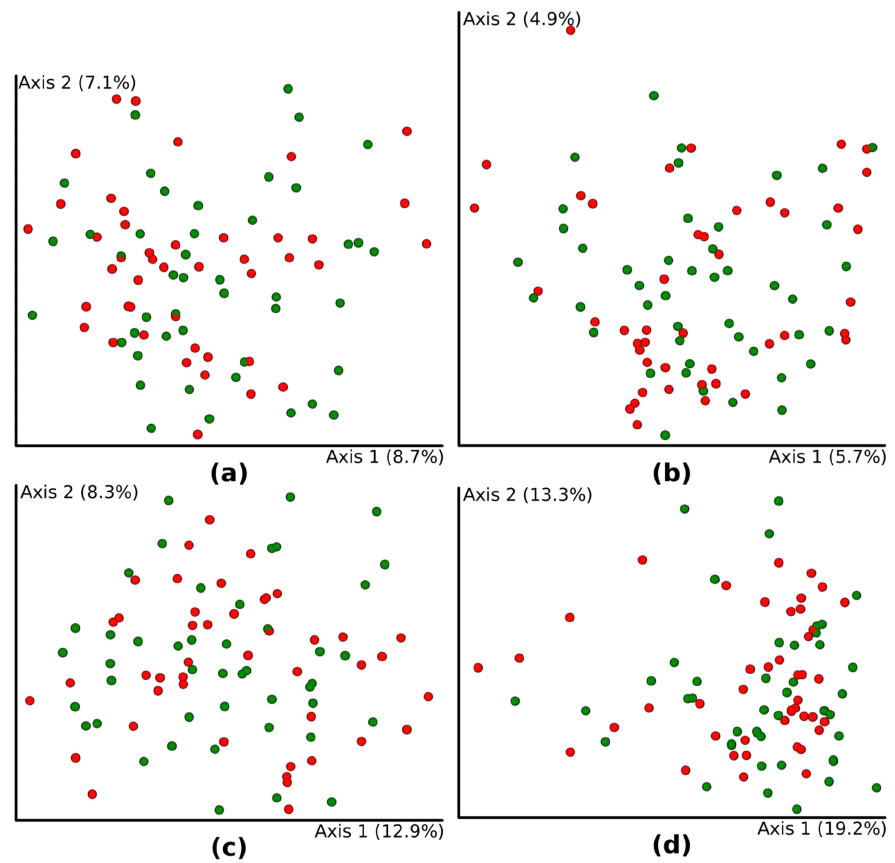
Figure 2. Principal coordinates analysis PCoA plots of beta diversity of patients with type 1 diabetes (T1DM) and with glycosylated hemoglobin (HbA1c) below 53 mmol/mol (7%) (green dots) and T1DM patients with HbA1c equal to or greater than 53 mmol/mol (7%) (red dots). Differences were presented as Bray–Curtis dissimilarity ( p = 0.18) ( a ), Jaccard distance ( p = 0.26) ( b ), unweighted UniFrac ( p = 0.59) ( c ), and weighted UniFrac ( p = 0.33) ( d ).